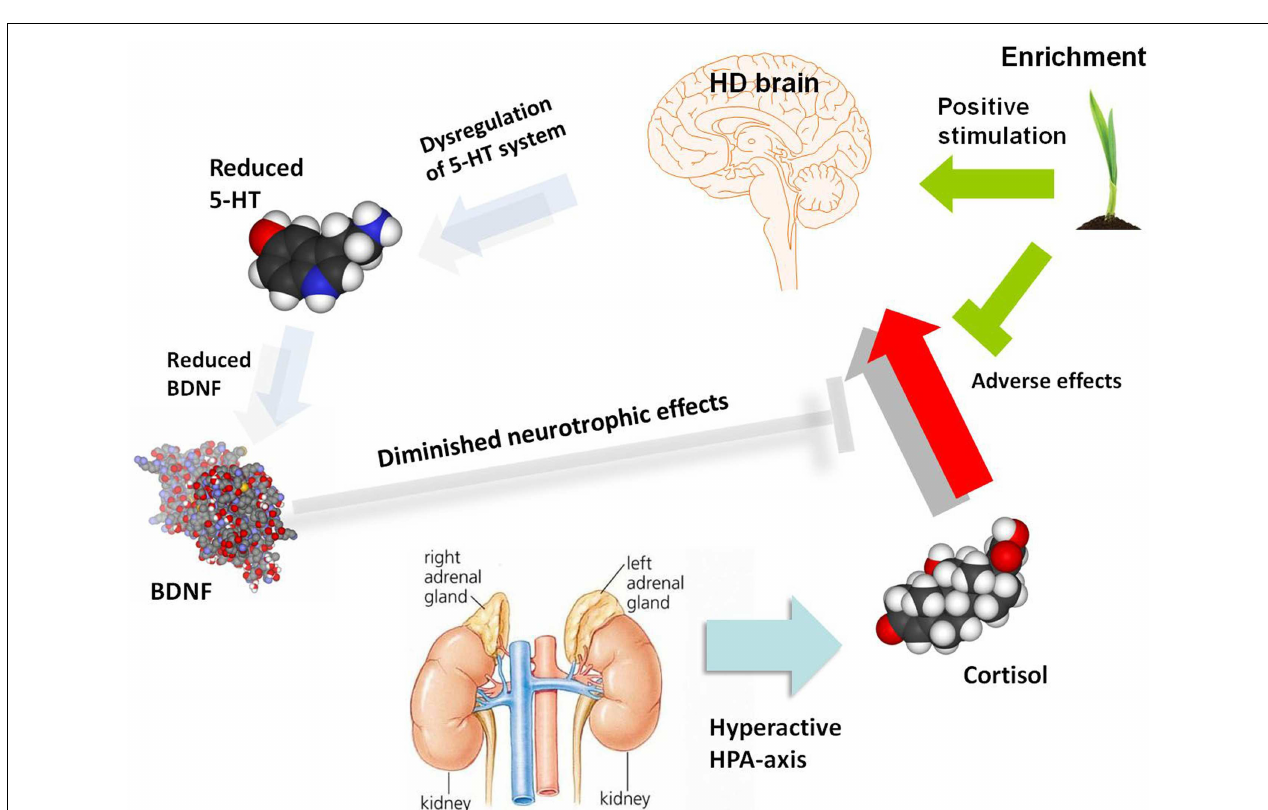
systems dysfunction is also illustrated.There are clearly many other molecular and cellular candidates implicated in HD pathogenesis which are not shown in this diagram, which outlines a specific hypothesis regarding the etiology of depression in HD. 5-HT, serotonin; BDNF, brain-derived neurotrophic factor; HD, Huntington’s disease; HPA-axis, hypothalamic-pituitary-adrenal